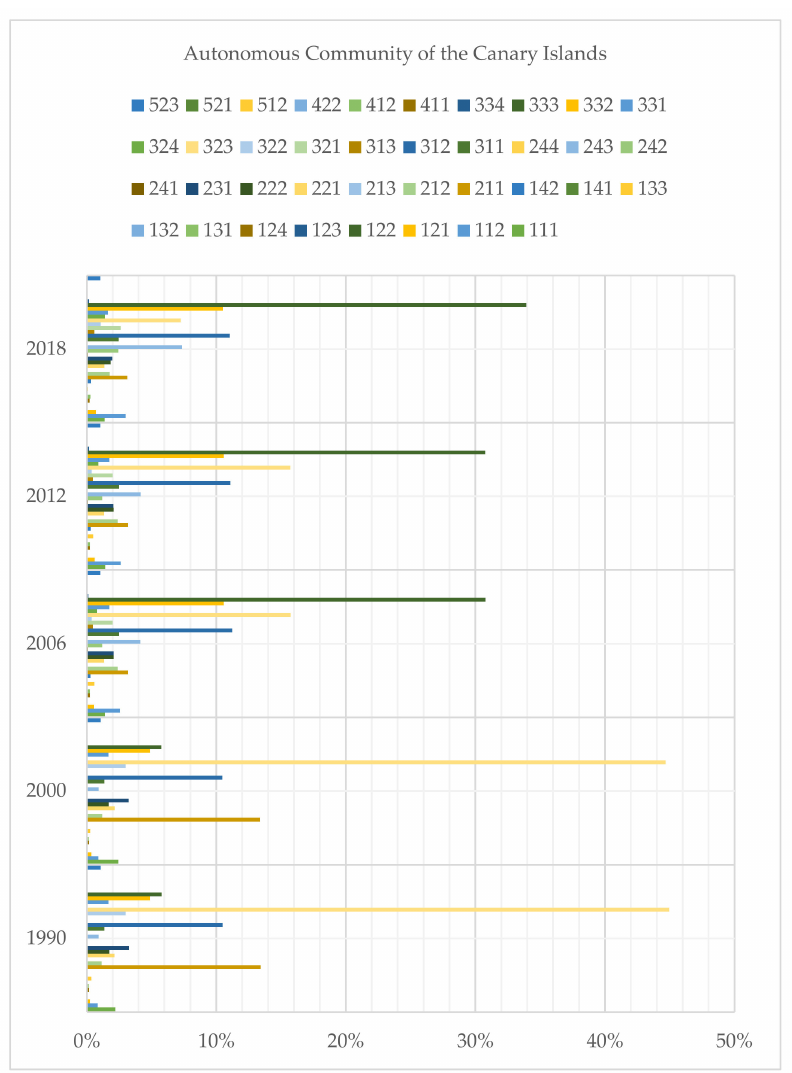
Figure 14. Percentage of land-uses according to CLC nomenclature in the Autonomous Community of the Canary